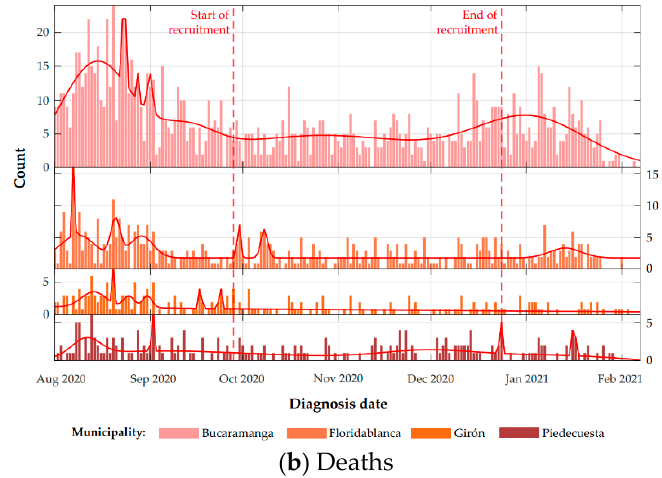
Figure 1. Reported SARS-CoV-2 daily confirmed cases and deaths for the municipalities of the Bucaramanga metropolitan area. ( a ) New daily confirmed cases, ( b ) Daily deaths. Dashed lines delimit the frame time in which recruitment was carried out (28 September and 24 December of 2020). Data source: Colombia National Health Institute; https://www.ins.gov.co/Noticias/Paginas/coronavirus-casos.aspx (accessed on 20 March 2021).